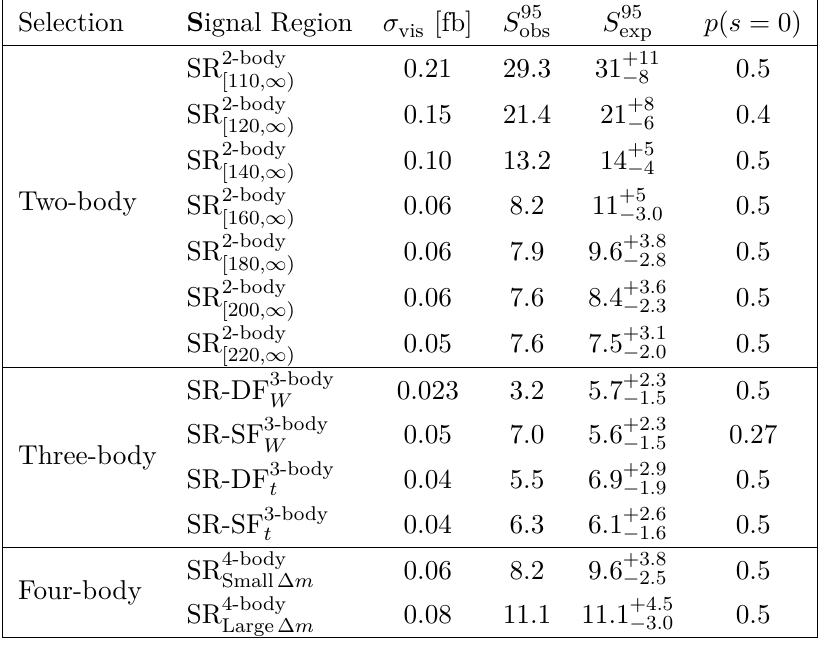
Table 19 . Model-independent 95% CL upper limits on the visible cross-section ( σ ) of new vis physics, on the visible number of signal events ( S 95 ), on the visible number of signal events ( S 95 ) obs exp given the expected number of background events (and ± 1 σ excursions of the expected number), and the discovery p -value ( p ( s = 0) ), all calculated with pseudo-experiments, are shown for each of the SRs. The p -value is reported as 0.5 if the observed yield is smaller than that predicted. its associated uncertainties in the CRs and SRs. All limits are quoted at 95% CL with the CL method. When setting limits, the two-body selection binned SRs SR-DF 2-body s [ x,y ) and SR-SF 2-body regions are combined. Similarly, the SR-DF 3-body , SR-SF 3-body W [ x,y )